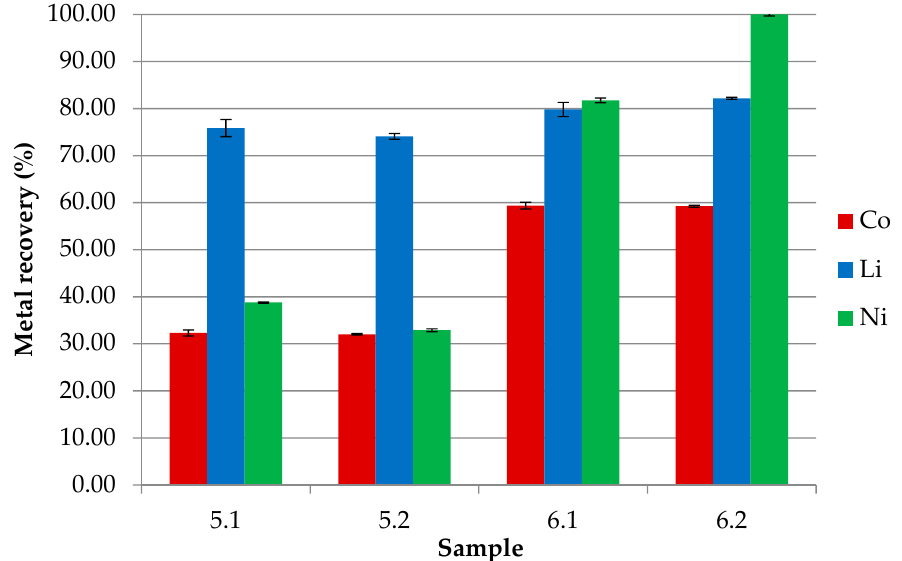
Figure 4. Recovery degrees for Co, Li, and Ni from solutions obtained by leaching with 1.5 M sulfuric acid with or without the presence of 5 g of glutaric acid and/or 3 cm 3 perhydrol.